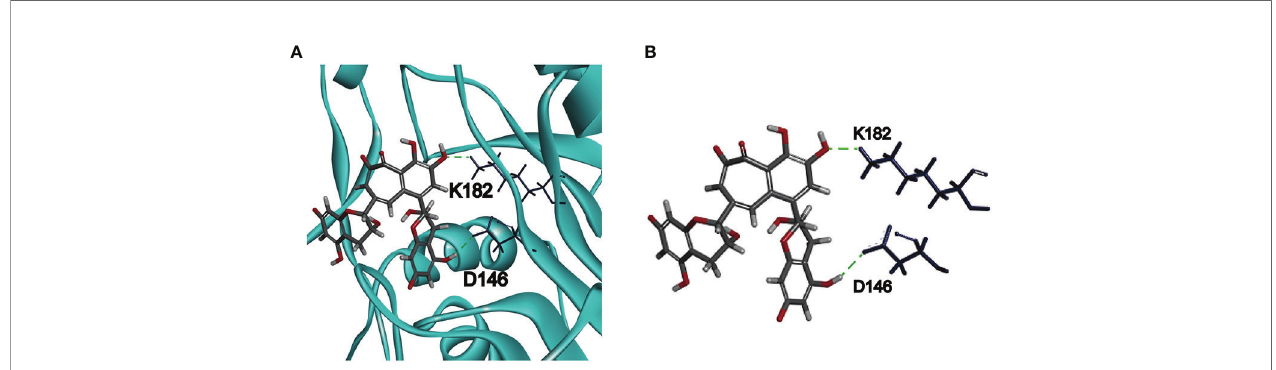
FIGURE 3 | Molecular docking of ZIKV NS5 MTase and thea fl avin. (A) The predicted pose of thea fl avin binding to the active pocket of ZIKV NS5 MTase. Thea fl avin is represented by a stick model (grey, carbon atoms; deep red, oxygen atoms; light grey, hydrogen atoms). The deep blue sticks represent the amino acids interacting with thea fl avin. (B) The detailed intermolecular bonds between ZIKV NS5 MTase and thea fl avin. The hydrogen bond between D146 and the hydrogen atom of thea fl avin is green. Hydrogen bond is also observed between K182 and oxygen atom of thea fl avin.